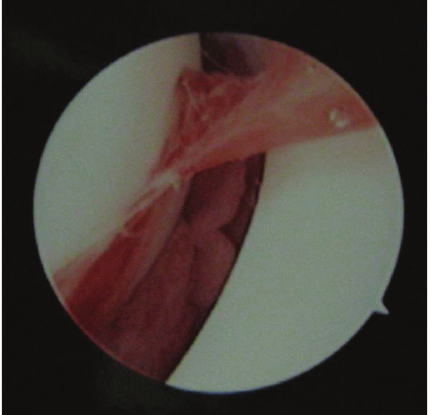
Figure 3: Arthroscopic observation of the right elbow. There was severe synovial proliferation in the